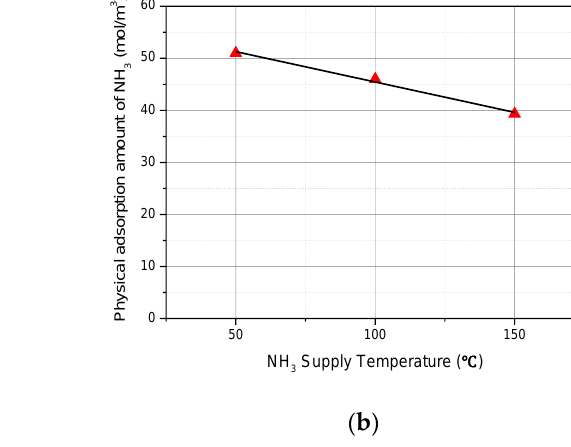
Figure 2. Variation of the physically adsorbed NH 3 amount according to the various parameters: ( a ) Effect of NH 3 supply time (inlet NH 3 concentration: 200 ppm, temperature of NH 3 absorption: 50 °C); ( b ) effect of NH 3 adsorption temperature (inlet NH 3 concentration: 200 ppm, NH 3 supply time: 7500 s).